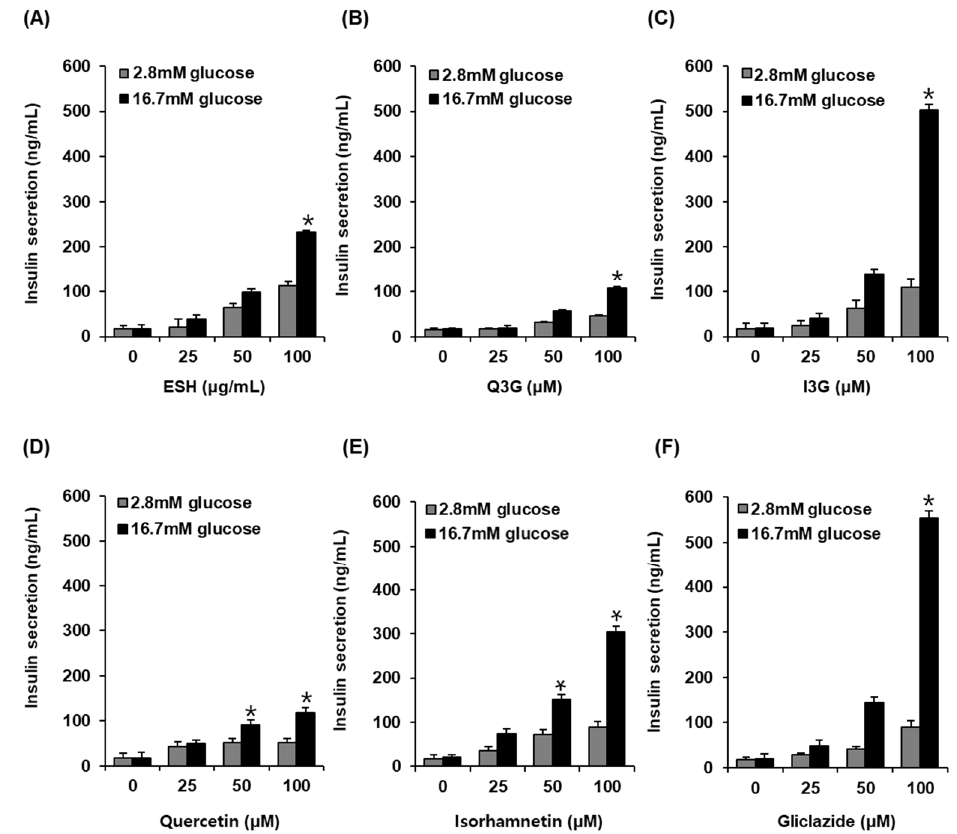
Figure 3. Effect of ( A ) ethanolic extract of Salicornia herbacea (ESH), ( B ) quercetin 3- O -glucoside (Q3G) ( C ) isorhamnetin 3- O -glucoside (I3G), ( D ) quercetin, ( E ) isorhamnetin, and ( F ) positive control (gliclazide) compared with that of the control (0 μM) on glucose-stimulated insulin secretion (GSIS) in INS-1 rat insulin-secreting β-cells for 1 h by insulin secretion assay ( n = 3 independent experiments, * p < 0.05, Kruskal–Wallis nonparametric test). Data are expressed as the mean ± SEM.